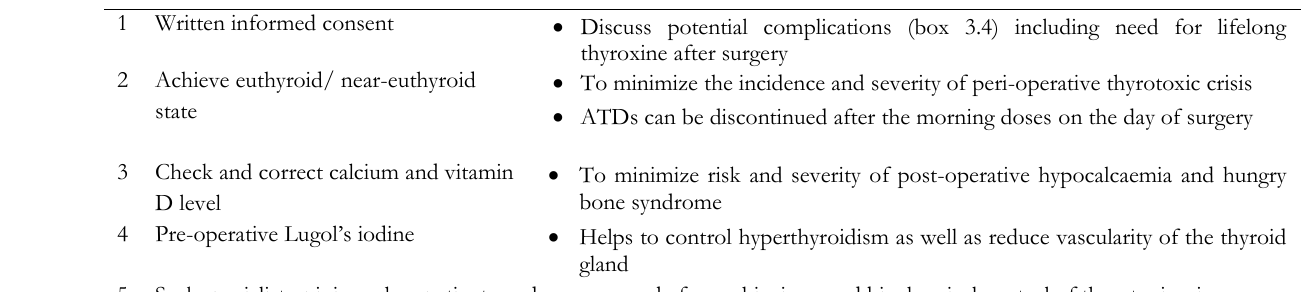
Table 3.12. Preparation for thyroidectomy